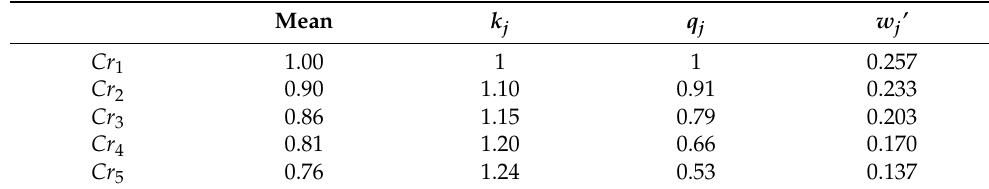
Table 8. Computational details and the criteria weights obtained by the PIPRECIA method based on mean values.